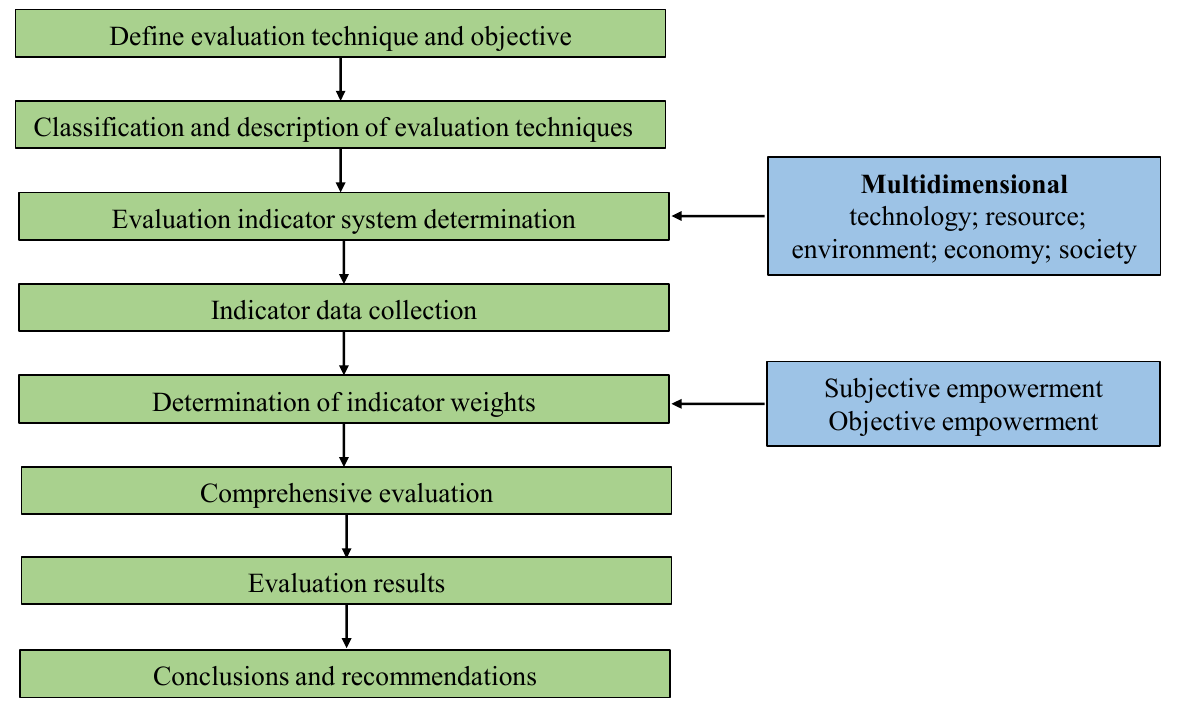
Table 1. Comprehensive evaluation indicators of ex situ thermal desorption remediation technol- ogy.